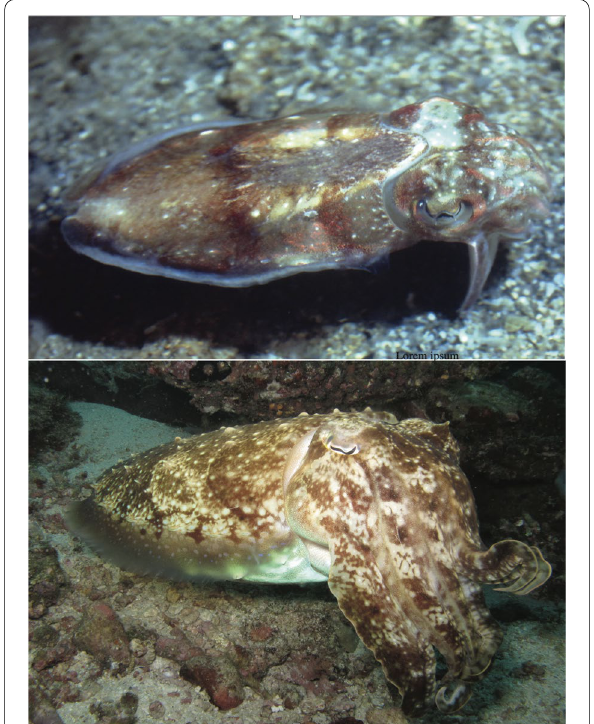
Fig. 2 Position of phragmocone within sepiid, showing relative positions of chambers, siphuncle, and cameral liquid within chambers in a growing sepiid. Below: cuttlebone of mature Sepia officinalis illustrating relevant morphology and measures made for this